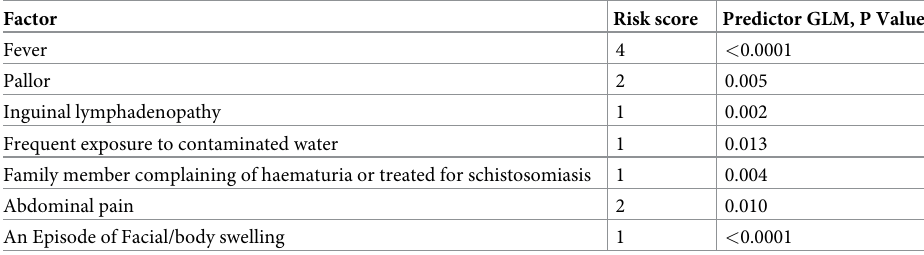
Table 5. Risk Scores for the Different Factors and Predictor